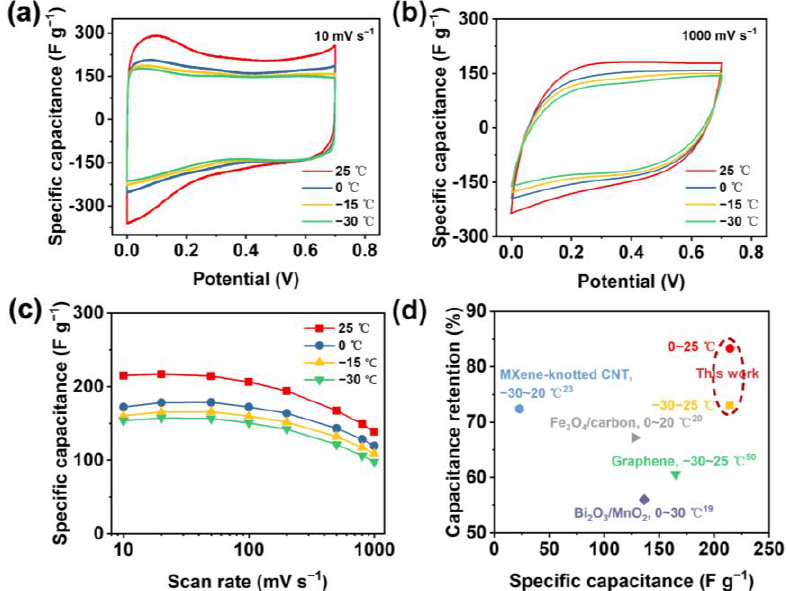
Figure 5. Low-temperature stability of aligned Ti 3 C 2 T x aerogel electrode in a two-electrode configu- ration. CV curves at ( a ) 10 and ( b ) 1000 mV s −1 at different temperatures; ( c ) Specific capacitance versus scan rate from 25 to −30 °C; ( d ) Comparison of specific capacitance near room temperature (in the range of 20 and 30 °C) and capacitance retention with previously reported supercapacitors.